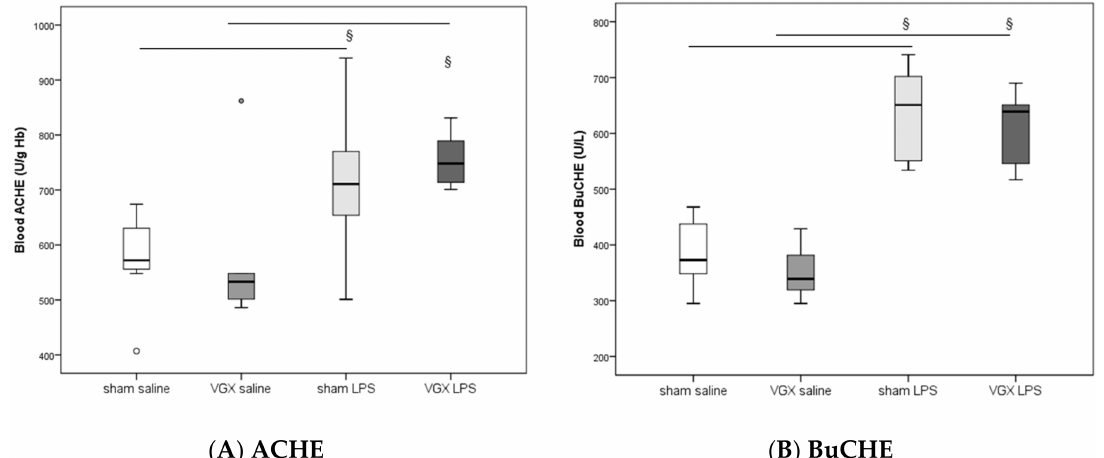
Figure 1. Blood cholinesterase (CHE) activities at the end of the experiments. Blood enzyme activity presented as median (IQR = Inter Quartile Range) at 4 h after LPS injection (T5). No significant effect of right cardiac vagus nerve resection (VGX) was observed ( p > 0.05). § : significant LPS effect for ( A ) acetylcholinesterase (ACHE, U/g Hb) activity (sham saline versus sham LPS, p = 0.031, and VGX saline versus VGX LPS, p < 0.001) and for ( B ) butyrylcholinesterase (BuCHE, U/L) activity (sham saline versus sham LPS, p < 0.001, and VGX saline versus VGX LPS, p < 0.001). The circles present outliers. LPS significantly increased acetylcholine in rat myocardium after a selective vagotomy of the right branch of the cardiac vagus nerve (VGX, Figure 2A: § : p < 0.05).